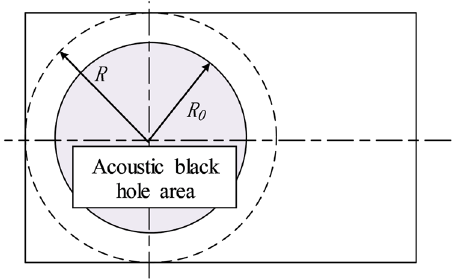
Figure 8: Diagram of the de fi nition of two - dimensional acoustic black hole